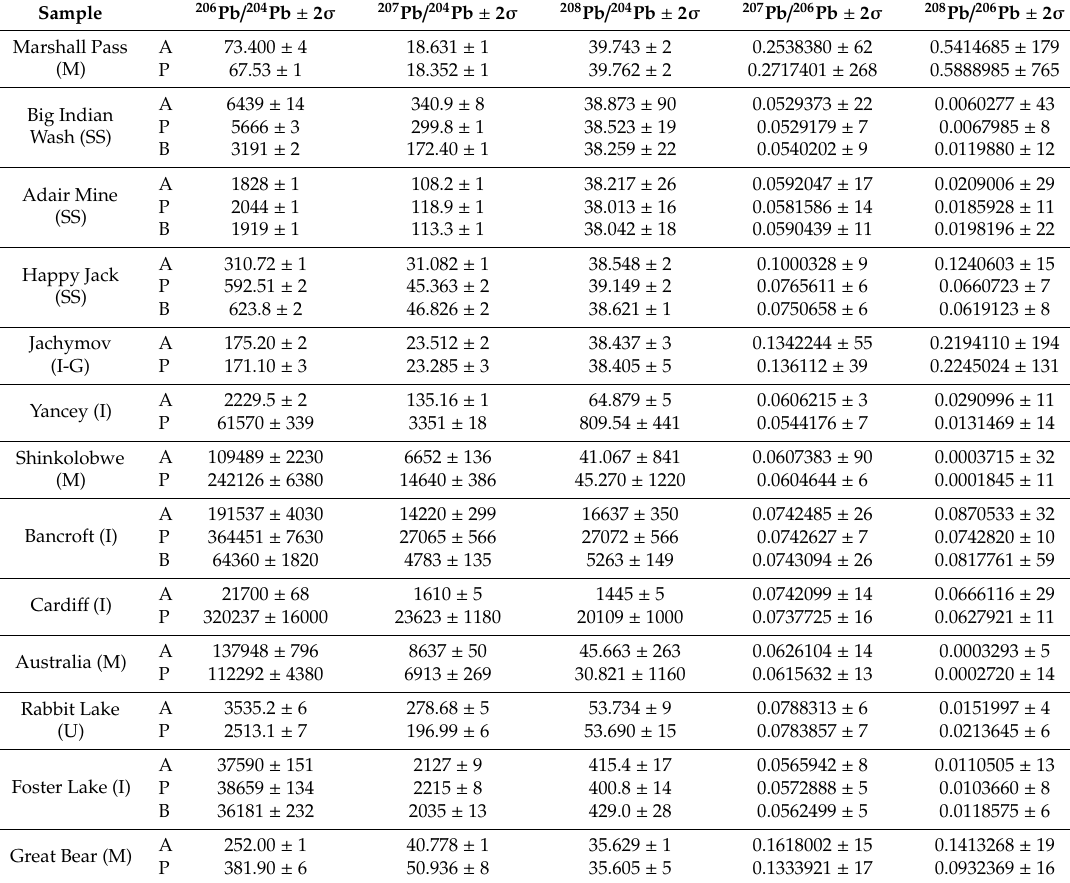
Table 2. Pb isotope compositions for samples (pristine, altered, and bulk) analyzed in this study. Sample